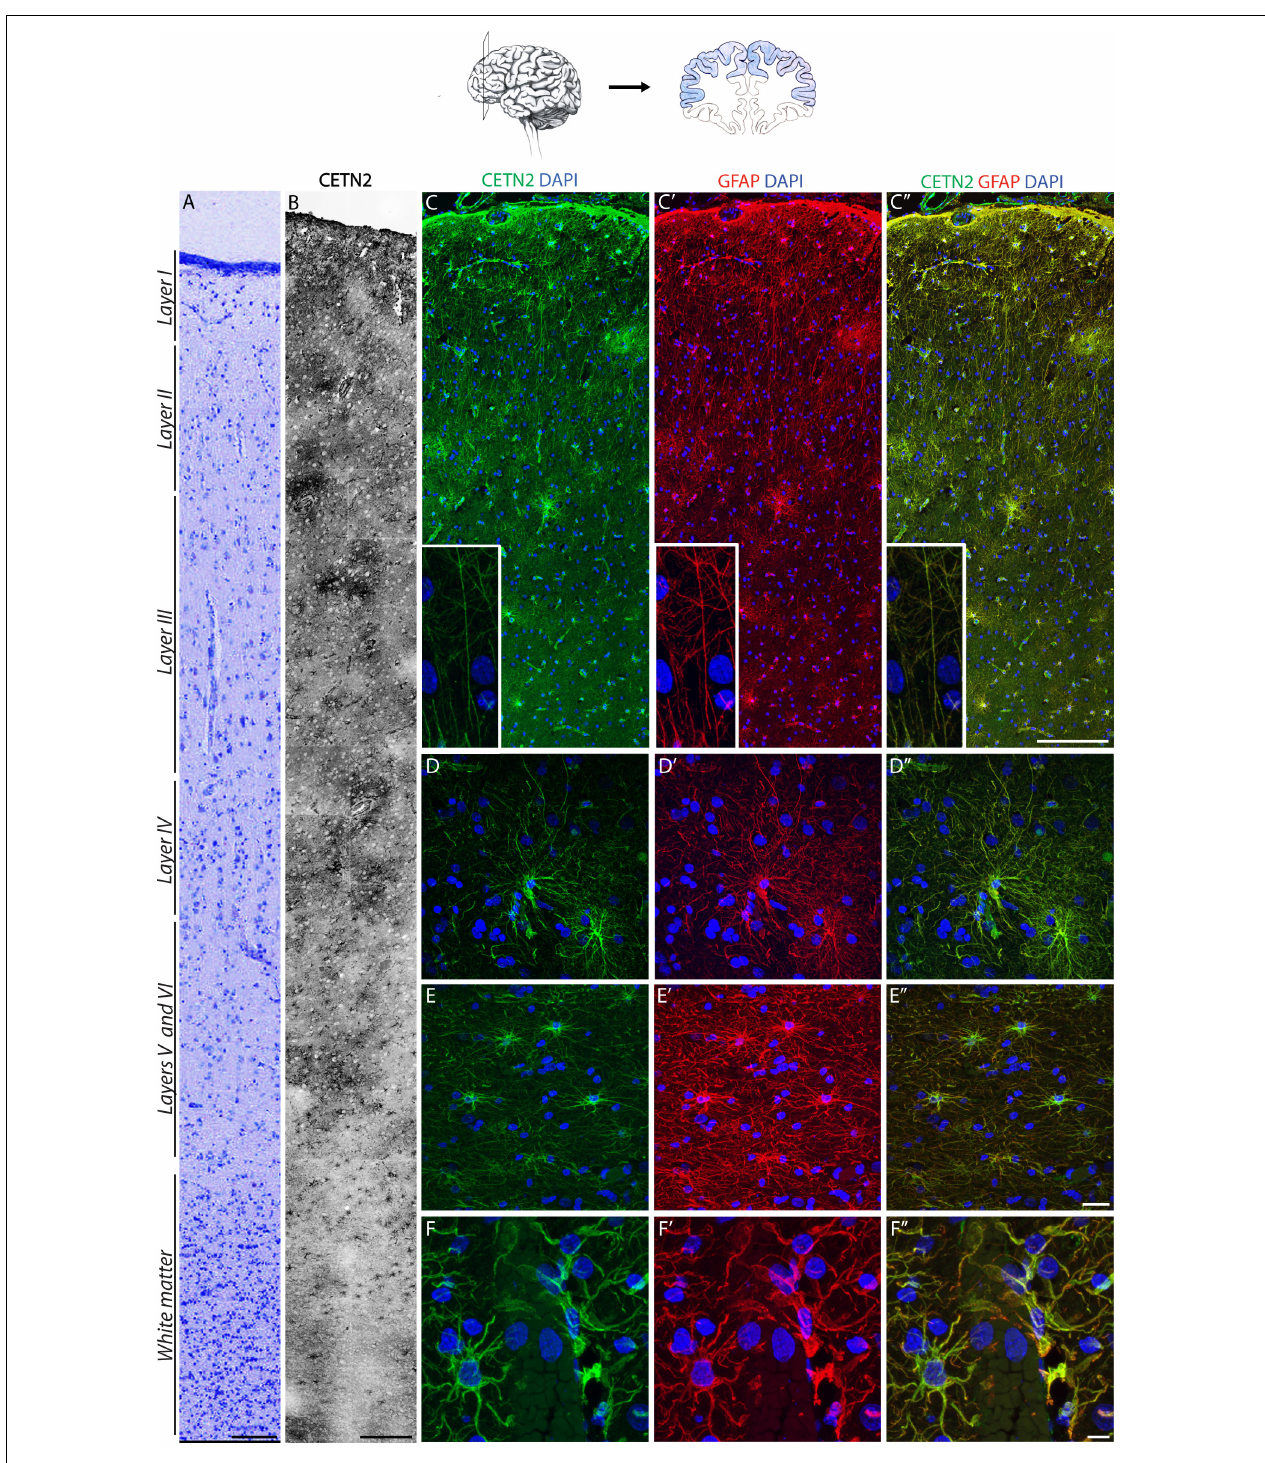
FIGURE 3 | CETN2 labels protoplasmic and fibrous astrocytes in the human cerebral cortex. (A) Human prefrontal cortex colored with Nissl staining. (B) CETN2 labels astrocytes in human prefrontal cortex across all layers, in gray and white matter. (C–C”) Interlaminar astrocytes in layer I show CETN2 immunopositivity and co-labeling with GFAP. Cell bodies reside in layer I and extend numerous long processes with typical tortuous morphology (shown in inset). (D–D”) Protoplasmic astrocytes, largely abundant in cortical gray matter across layers II to VI, also exhibit CETN2 immunopositivity. (E–E”) Fibrous astrocytes in cortical white matter visualized by CETN2 and GFAP immunolabeling. (F–F”) CETN2 and GFAP immunolabeling of astrocytic end feet tightly surrounds cerebral blood vessel. Scale bars: (A) 100 µ m; (B) 250 µ m; (C–C”) 200 µ m; (D–D”), and (E–E”) 20 µ m; (F–F”) 10 µ m.